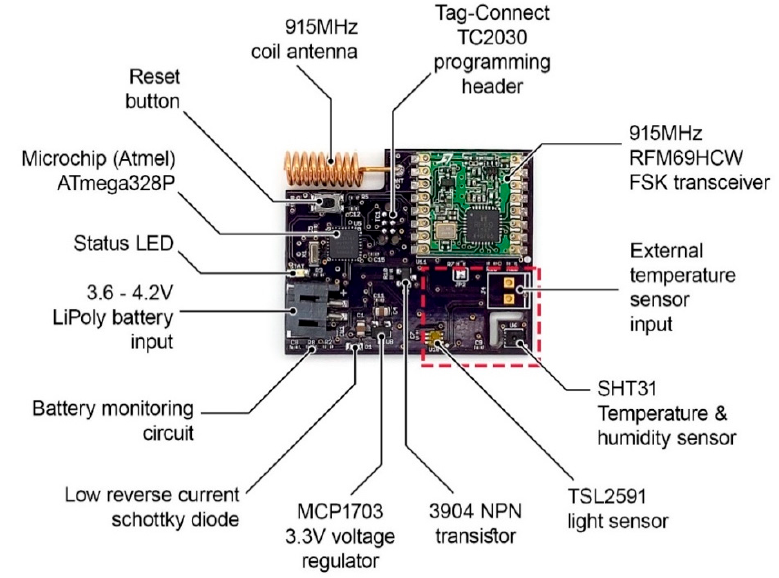
Figure 3. Various components of a typical wireless sensor node (in this case, the node is the same as in Figure 2a and includes temperature, relative humidity, and light sensors).